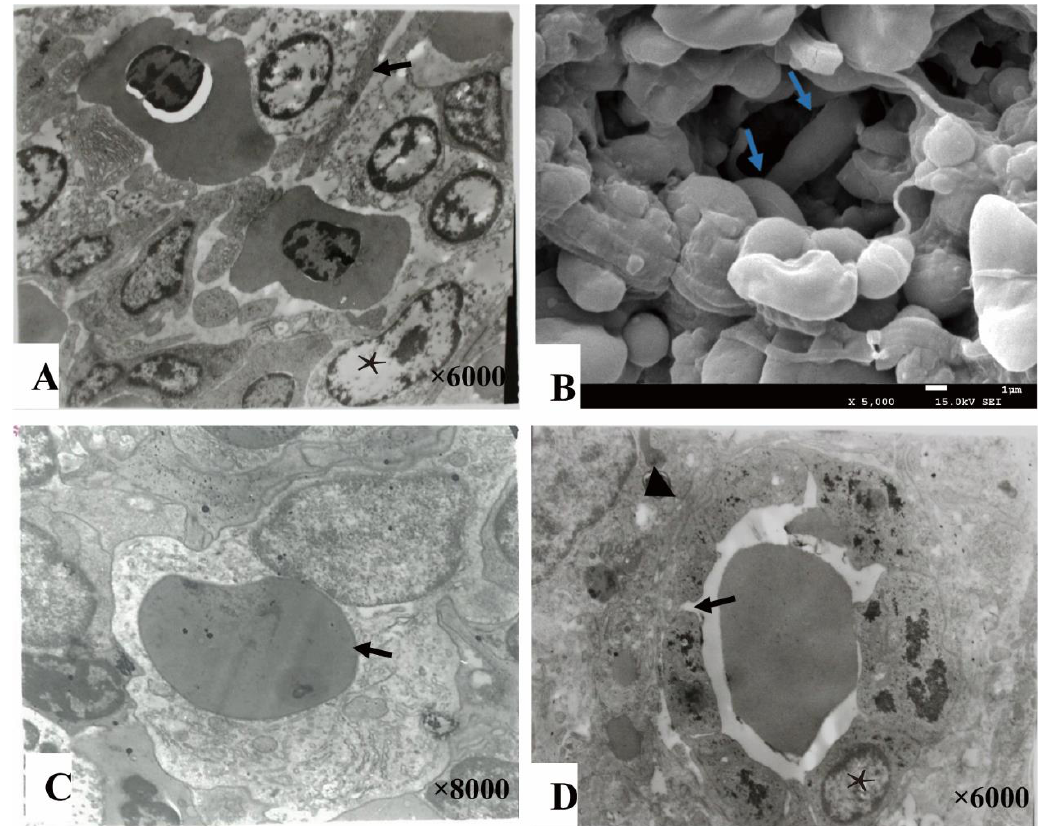
Figure 4. The splenic cord and ellipsoid. ( A ). The reticular cells ( ★ ) were adjacent with each other forming net mast allowing deformable erythrocytes ( → ) to pass through (TME); ( B ). The splenic net, formed by reticular cells allowing the erythrocytes ( → ) to pass through post deformation (SEM); ( C ). An erythrocyte ( → ) engulfed by a monocyte cell; ( D ). The ellipsoid consisted of cuboidal-shaped endothelial cells ( ★ ) by gap junction ( → ), and surrounded by fibers ( ▲ ).